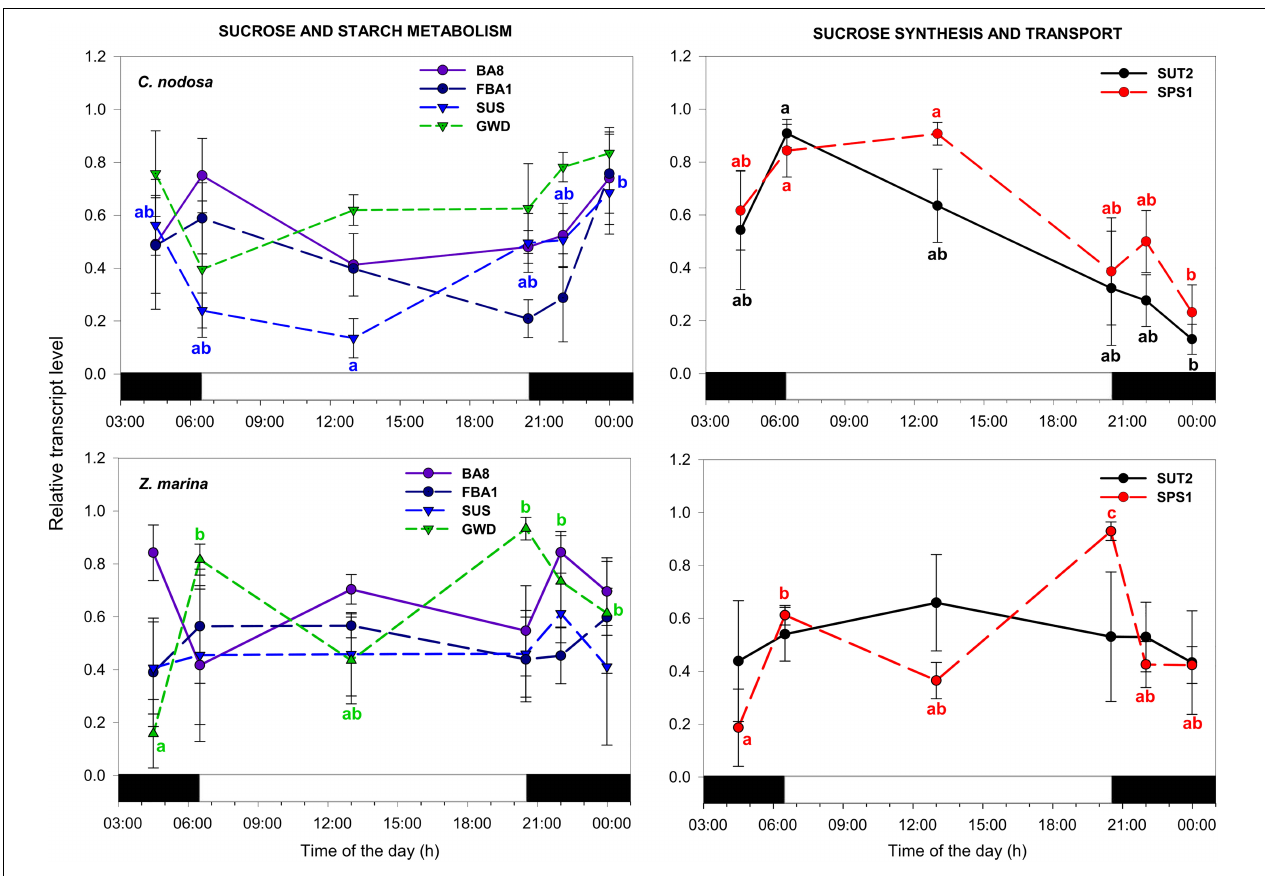
FIGURE 3 | Daily transcript levels (as normalized – (cid:49) CT data) of GOIs with a function in sucrose and starch metabolism, and sucrose synthesis and transport in C. nodosa (upper panels) and Z. marina (lower panels). Significant daily changes ( P < 0.05) for each GOI based on SNK tests following one-way ANOVAs ( Tables 3 , 4 ), are indicated with different letters. Letters are coloured as the respective GOI. Values are mean ± SE for n =